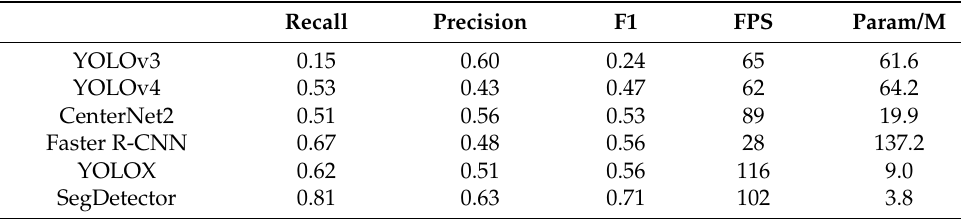
Table 5. Evaluation indexes of models such as SegDetector and